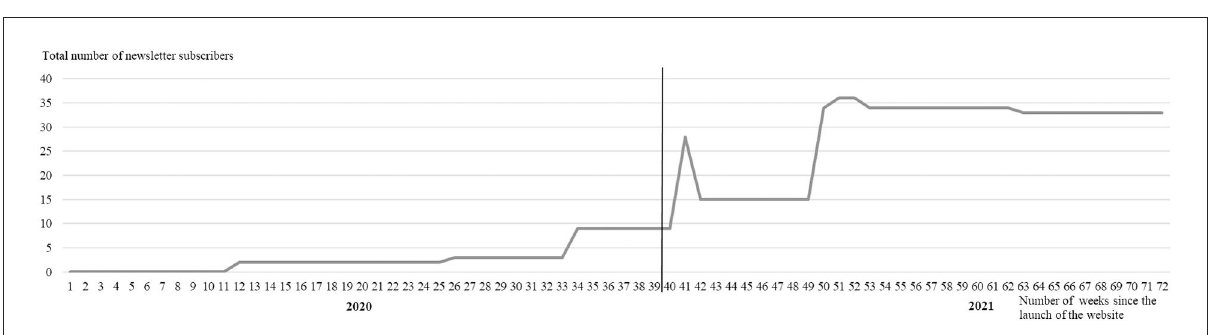
FIGURE3 Total number of newsletter subscribers over time. Note: 0 between week 1 and 11 caused to later starting of newsletter dispatch compared to activation of the